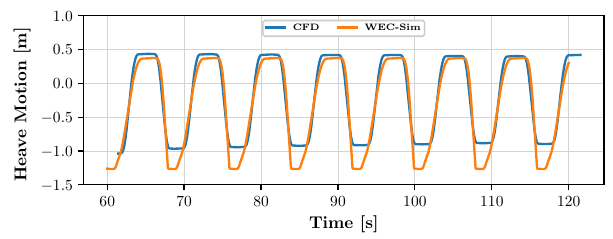
Fig. 7. Heave response time series for WEC moving only in heave (1 DoF case)